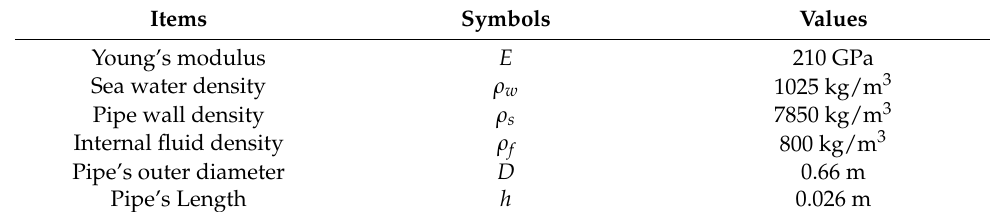
Table 2. Major parameters of the top-tensioned riser and the environment.